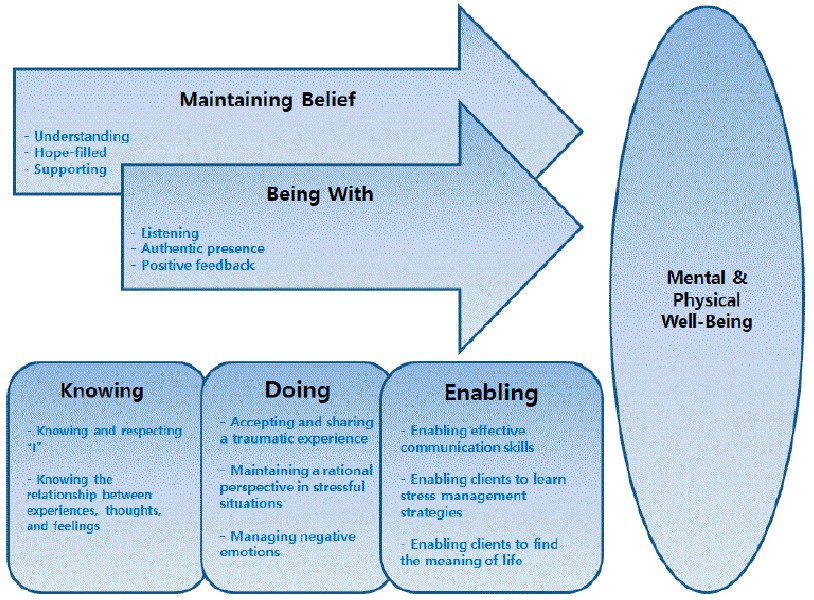
Figure 1. Conceptual framework for the program.